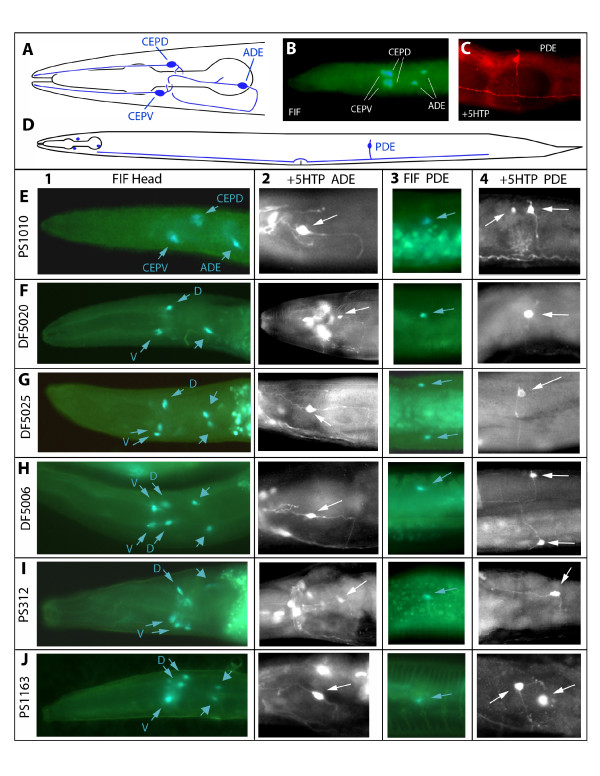
Dopaminergic neurons in free-living Rhabditid nematodes. A. Schematic of C. elegans head showing dopaminergic (DA) neurons on one side; each neuron has a bilaterally symmetric partner. CEPD: dorsal cephalic neuron; CEPV: ventral cephalic neuron; ADE: anterior deirid neuron. In all images, anterior is to the left, and dorsal up (except as noted). B. FIF-treated C. elegans larval head showing DA neurons (dorsoventral view) on right and left sides. C. PDE (posterior deirid neuron) neuron in lateral, mid-posterior body wall of C. elegans treated with 5HTP and stained with anti-serotonin (TRITC-conjugated secondary antibody). A dorsally directed dendrite arises from the soma: an axon extends ventrally and projects within the ventral nerve cord. D. Schematic of C. elegans body showing locations of DA neurons, including the PDE. Only the somata are shown for the head DA neurons. E-J. Dopaminergic neurons in species we examined, revealed by FIF and immunofluoresence. The pattern of DA cells in C. briggsae is identical to that of C. elegans (data not shown). Column 1 (FIF Head): FIF-treated worm heads. Slender-headed arrows indicate presumptive CEPD and CEPV homologs (in F-J, abbreviated D or V). Broad arrowheads indicate presumptive ADE homologs. In some panels both right and left cells can be seen (more than one arrow). Column 2 (+5HTP ADE): Putative ADE homologs visualized with anti-serotonin in 5HTP-treated worms (somata indicated with arrow). Soma locations and processes are quite similar to those in C. elegans, although many ADE posterior-directed neurites leading to commissures are longer than illustrated for C. elegans. Some panels are montages of nearby planes of focus to better show the cell morphology. Column 3 (FIF PDE): Lateral, mid-posterior body wall of FIF-treated worms showing somata of likely PDE homologs (arrow); in some panels both right and left cells can be seen (more than one arrow). Strong gut fluorescence often makes PDEs difficult or impossible to see by FIF. Column 4 (+5HTP PDE): PDE homologs in body wall visualized with anti-serotonin in 5HTP-treated worms (soma indicated by arrow); in some panels both right and left cells can be seen (more than one arrow), although sometimes the soma is out of the plane of focus. E. Caenorhabditis sp. 3 (PS1010). F. Oschieus myriophila (DF52020). G. Pellioditis typica (DF5025). Panel G3 (FIF PDE) is a ventral view showing both left and right PDE somata. H. Rhabditella axei (DF5006). Panel H4 (+5HTP PDE) is a ventral view in which both left and right cells can be seen. I. Pristionchus pacificus (PS312). In panel I4 (+5HTP PDE), note the long anteriorly directed PDE dendrite. J. Panagrellus redivivus (PS1163).